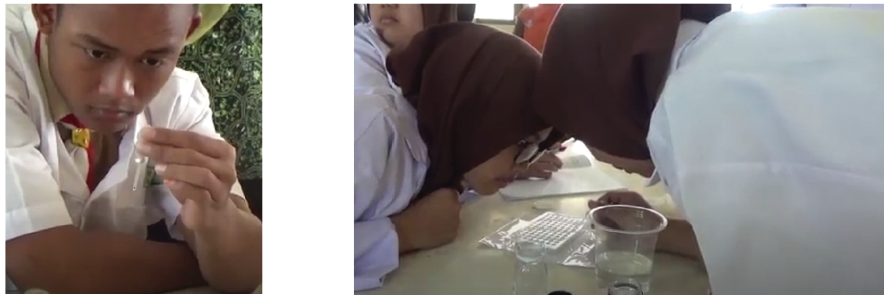
Figure 7. Expression of students’ curiosity in the process of finding the accuracy of the solution dripping process Students have a unique experience in the process of counting the number of droplets because it requires concentration and careful observation. One of the experiences is shown of the group in the process of completing the filling of holes on a 96-well microplate as shown in the dialogical footage. [S1]: (while pointing at one of the holes), this one is filled with zero drops, right?. (pointing to the hole next to the one previously indicated), this one is filled with 1 drop, right?